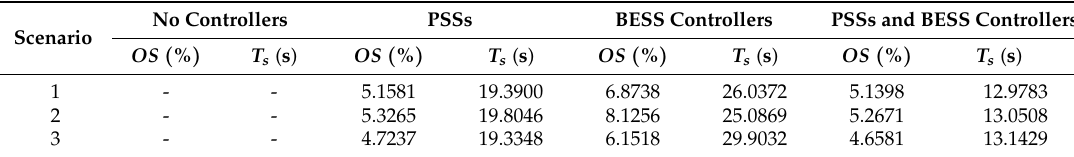
Table 12. Comparison of time responses of P 53–54 using the proposed method.